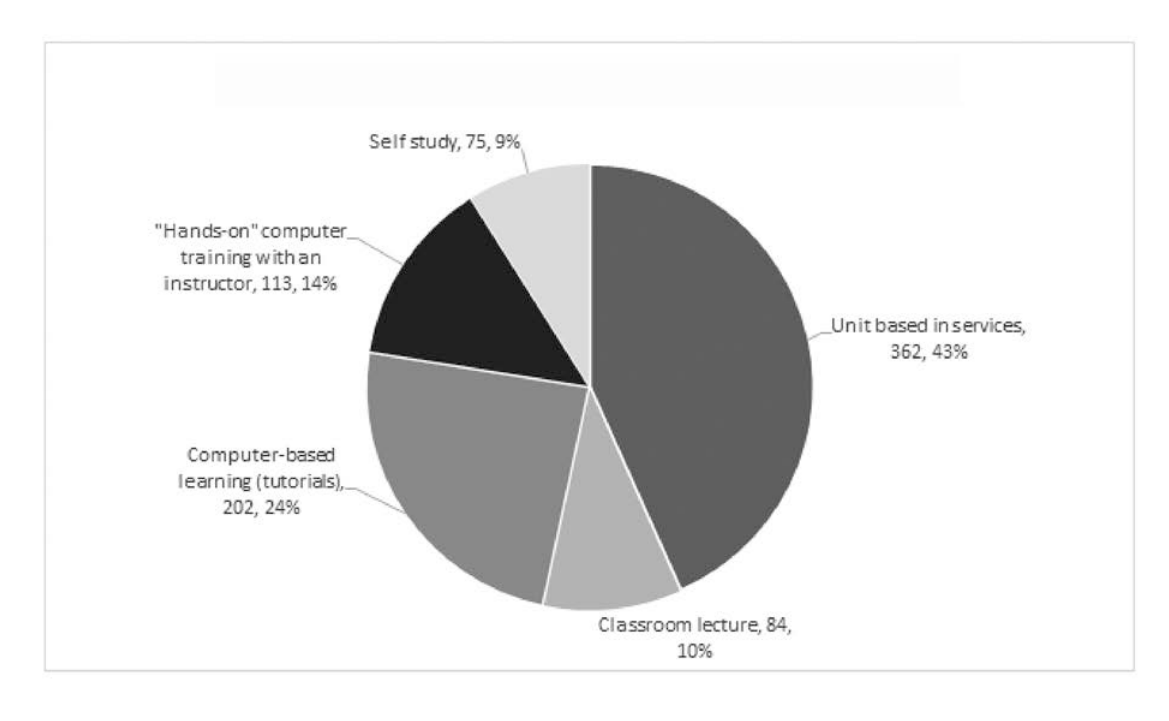
Figure 1 Preference for receiving education (first